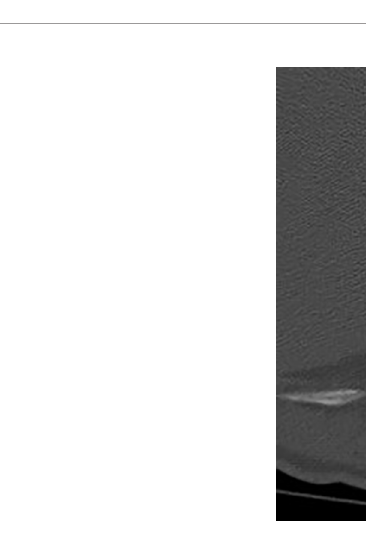
FIGURE 5 | Axial thoraco-lumbar CT scan showing L1 metastatic lesion with altered bone density and osteolytic